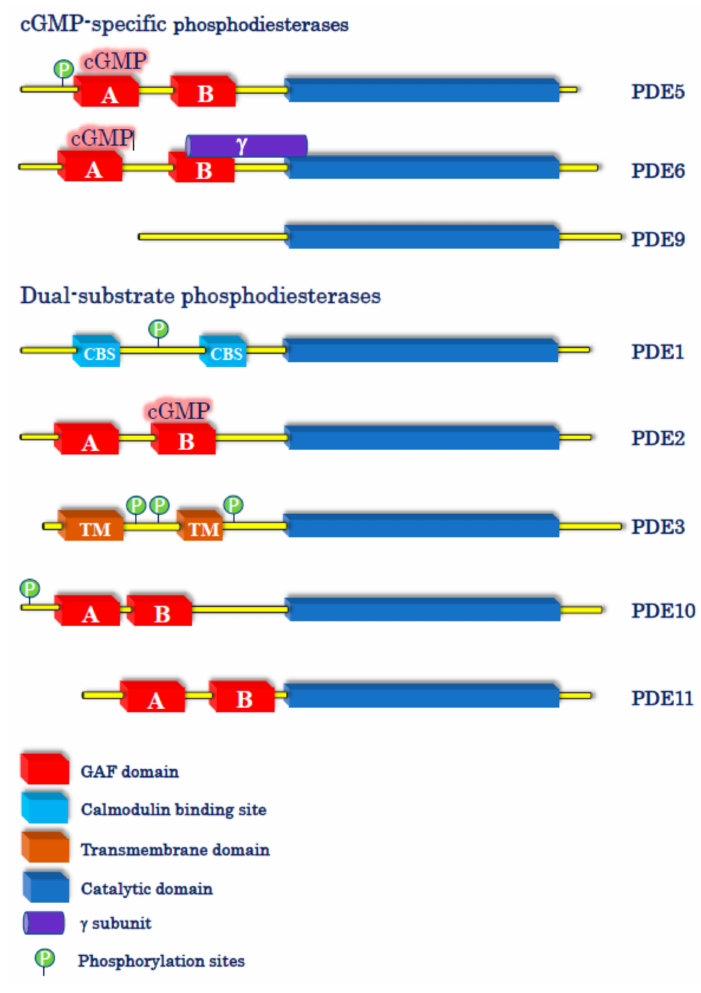
Figure 1. Schematic representation of cyclic guanosine-3 (cid:48) ,5 (cid:48) -monophosphate (cGMP)-specific and dual-substrate phosphodiesterases (PDEs). The figure shows the three PDEs that specifically hy- drolyze cGMP (PDE5, 6, and 9) and the five PDEs (PDE1, 2, 3, 10, and 11) that hydrolyze both cAMP and cGMP, although to a different